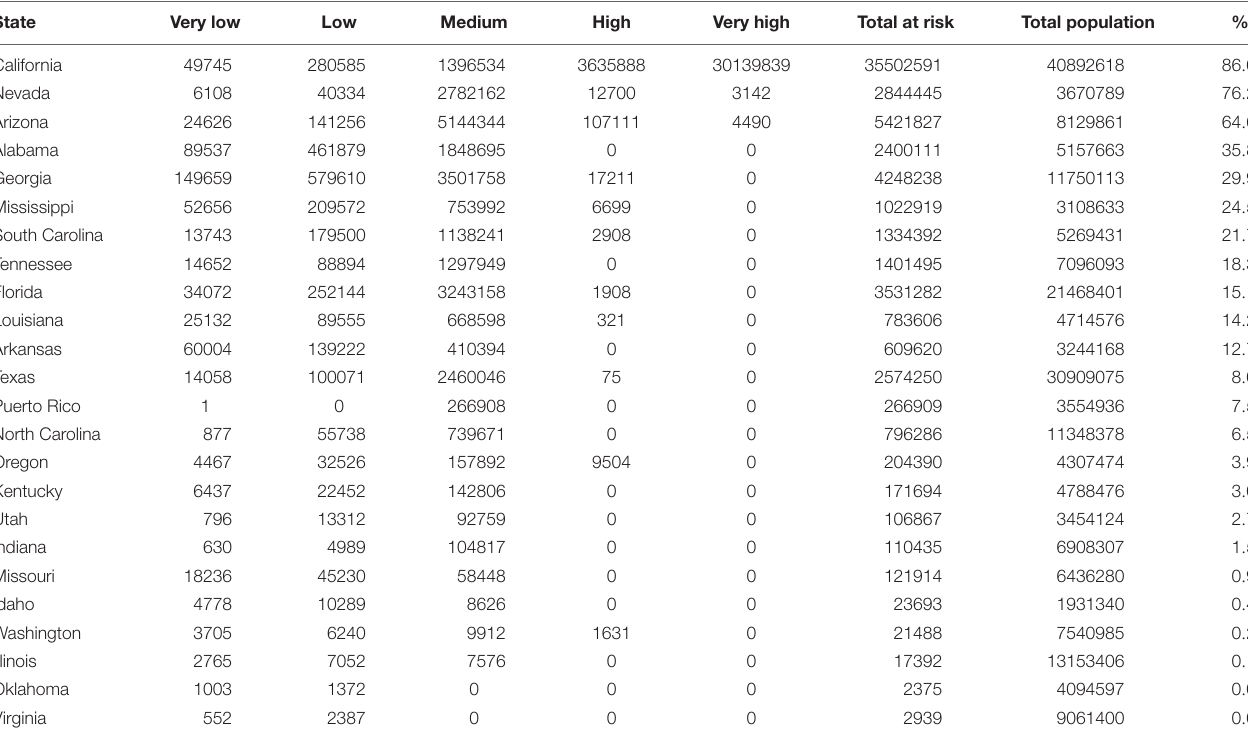
TABLE 2 | Population per risk level and region in the United